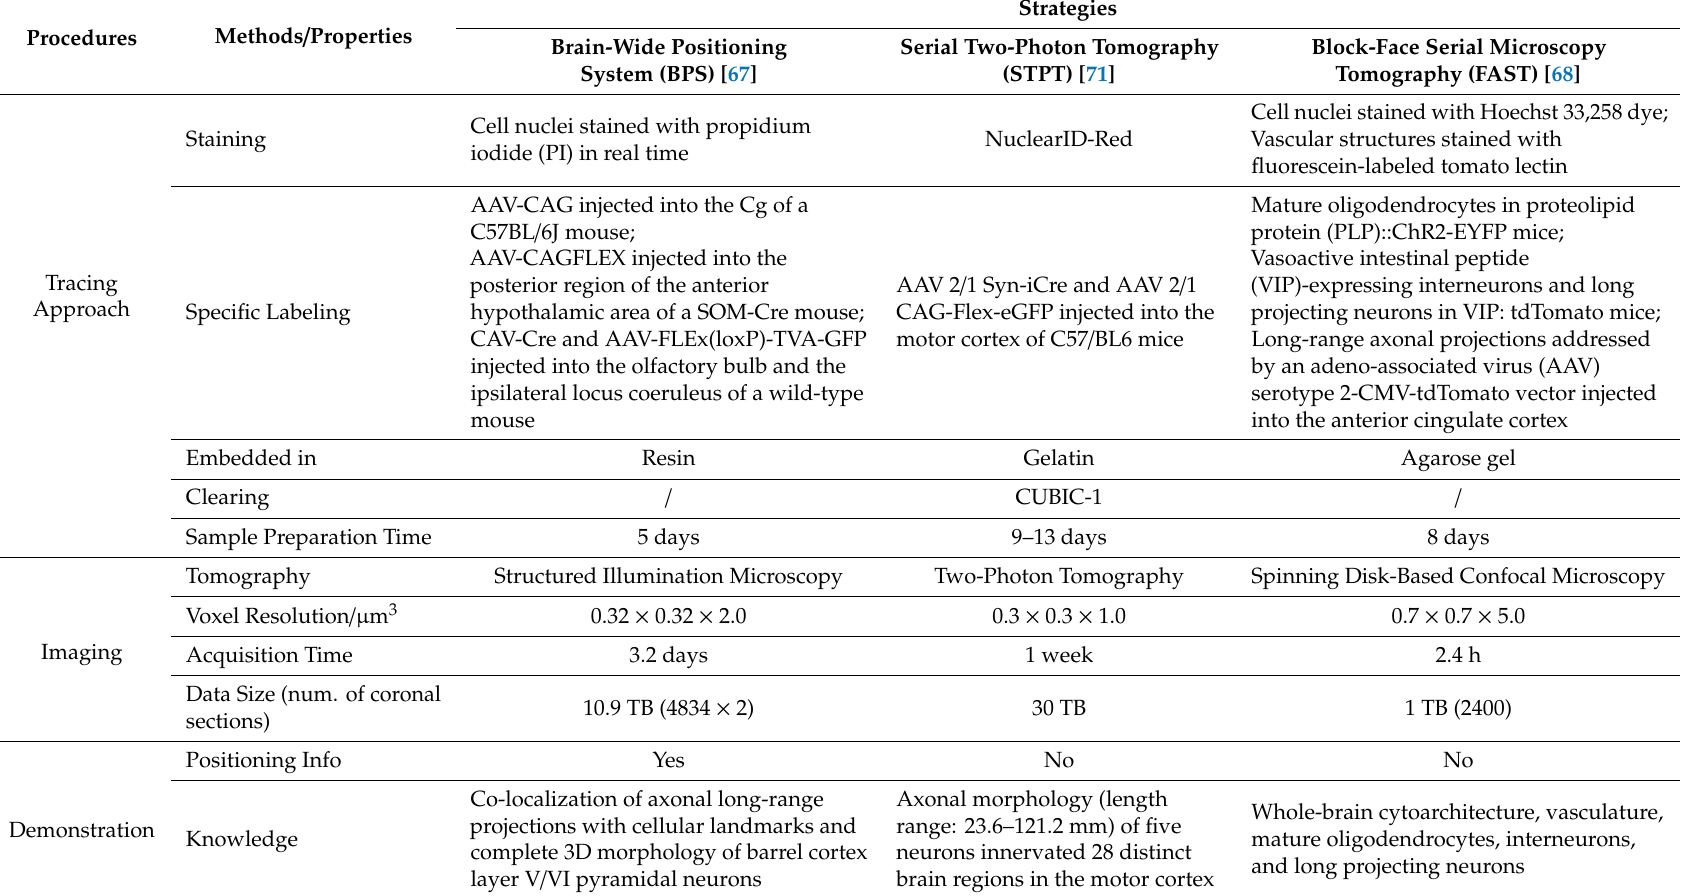
Table 1. Typical practices of whole-brain fluorescence imaging with single-neuron